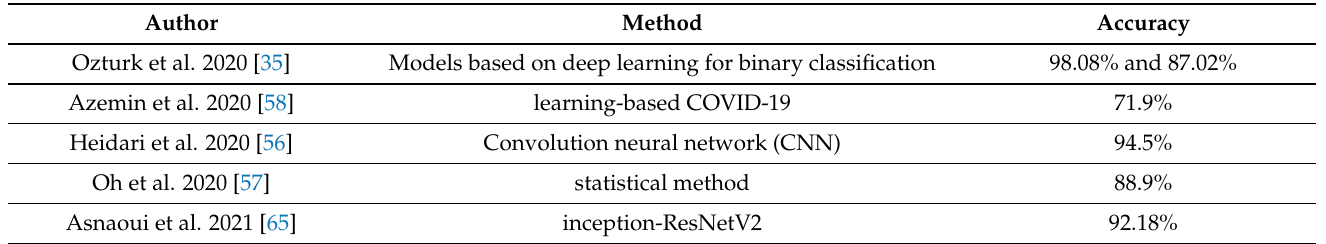
Table 5. Comparison between the performance of the existing approaches and the suggested